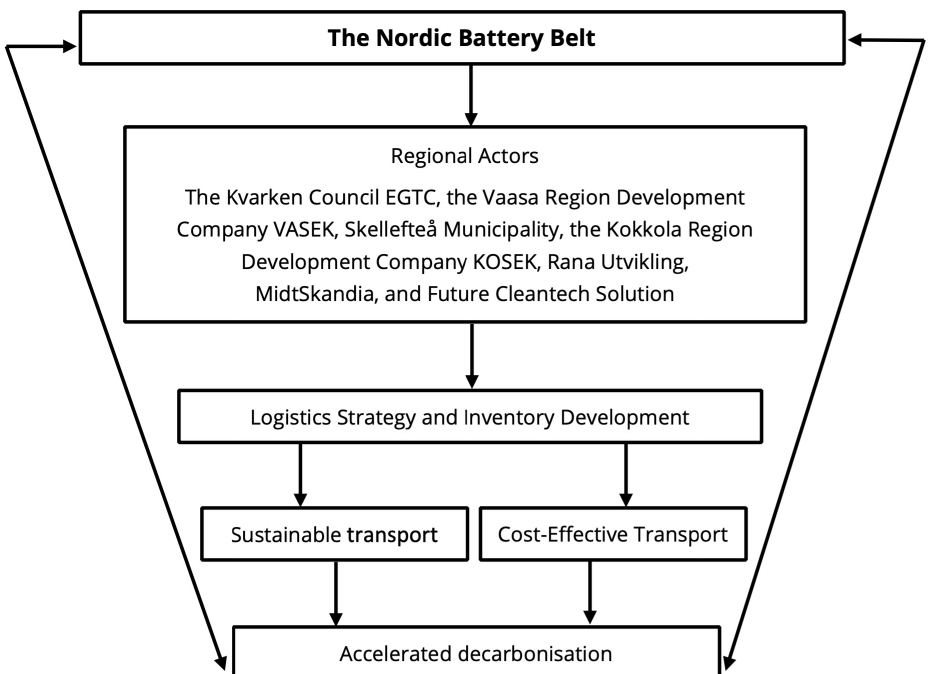
Fig. 1. An illustrative summary of the Nordic Battery Belt